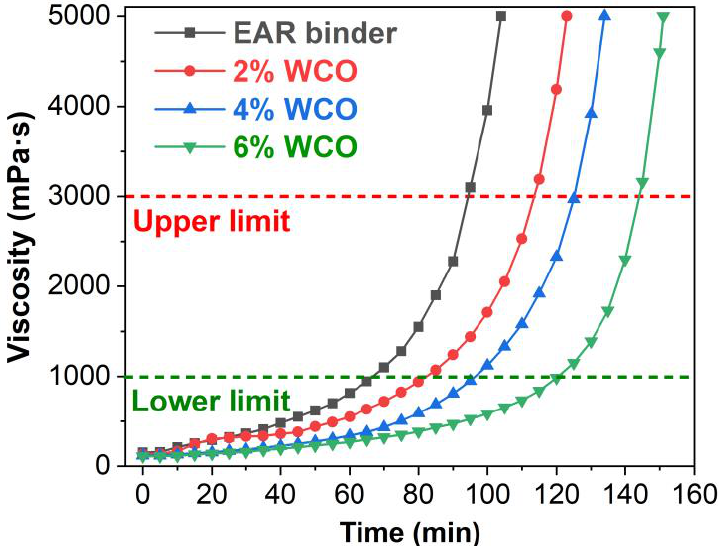
Figure 1. Rotational viscosity as a function of curing time of the unmodified and WCO-modified EAR binders at 160 °C.